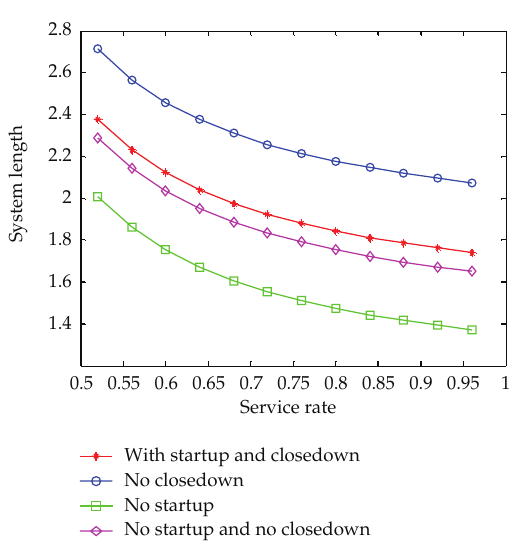
Figure 3: Plot of mean length in the system versus service rate with λ (cid:5) 0 . 3, N ∼ Du (cid:3) 1 , 5 (cid:4) , S ∼ Geo (cid:3) 0 . 4 (cid:4) , C ∼ Geo (cid:3) 0 . 5 (cid:4) , and B ∼ Geo (cid:3) α (cid:4) , the values of service rate α varying from 0.52 to 096 by the increment 0.04.